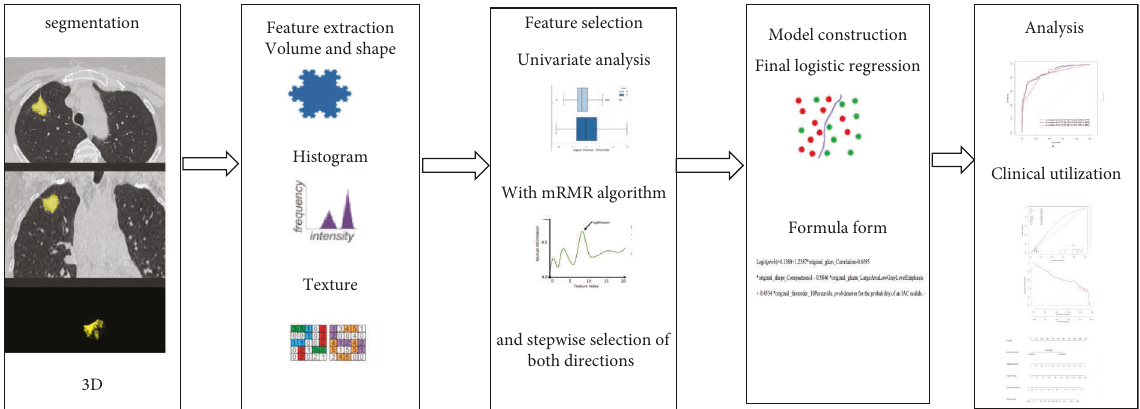
Figure 1: Flowchart of texture modeling